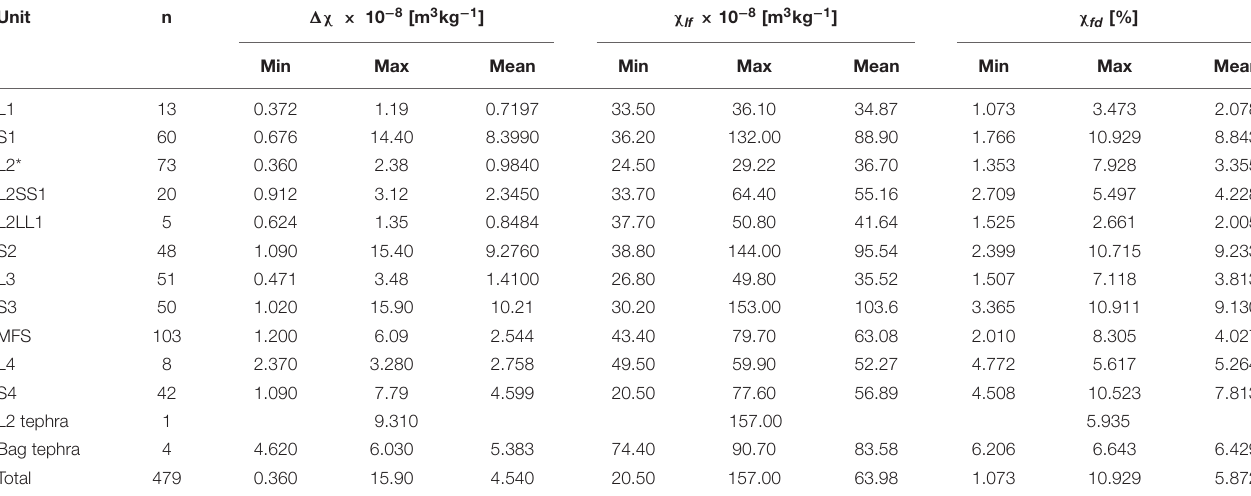
TABLE 2 | Minima, Maxima and Mean values for the different stratigraphic units.